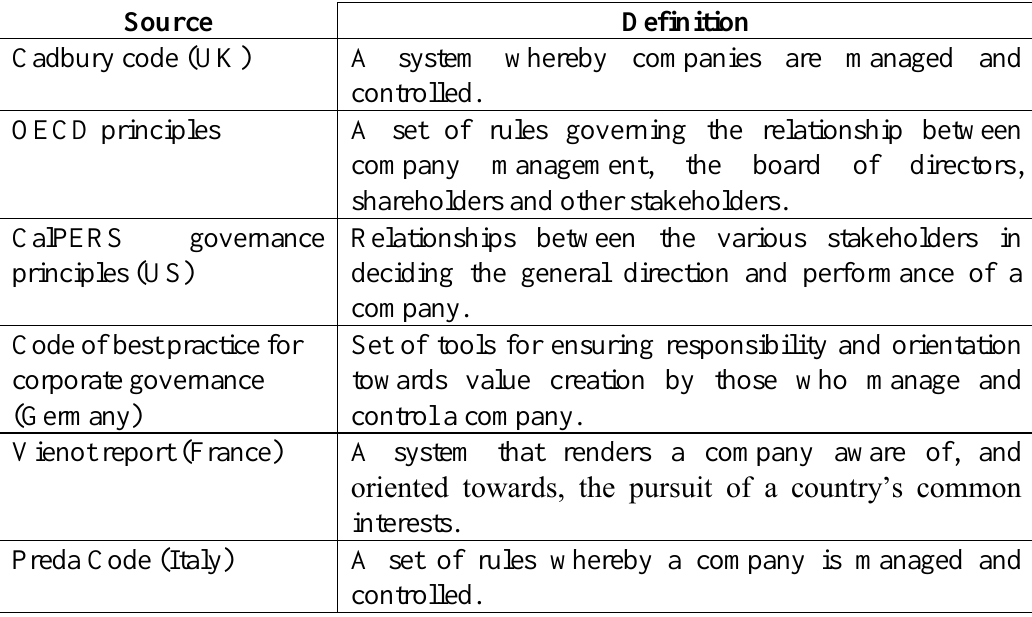
Figure 1: A Comparison of Corporate Governance Definitions Source Definition